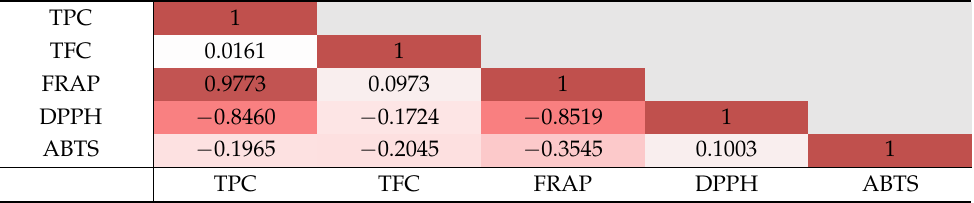
Table 6. Correlation coefficient